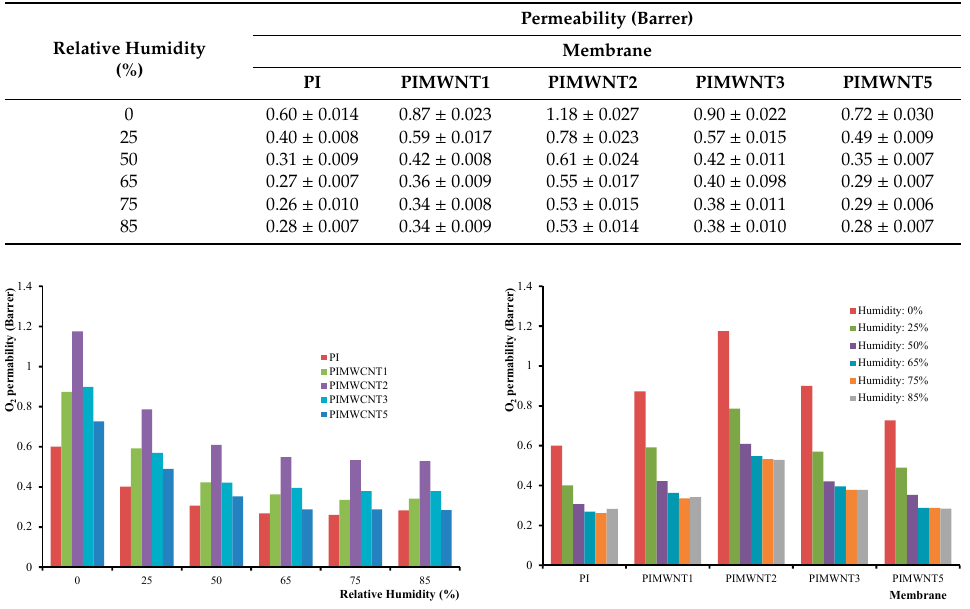
Figure 8. O 2 permeability diagrams as a faction of relative humidity ( left ) and of different MWCNTs percentage into the mixed matrix polyimide membranes ( right ).